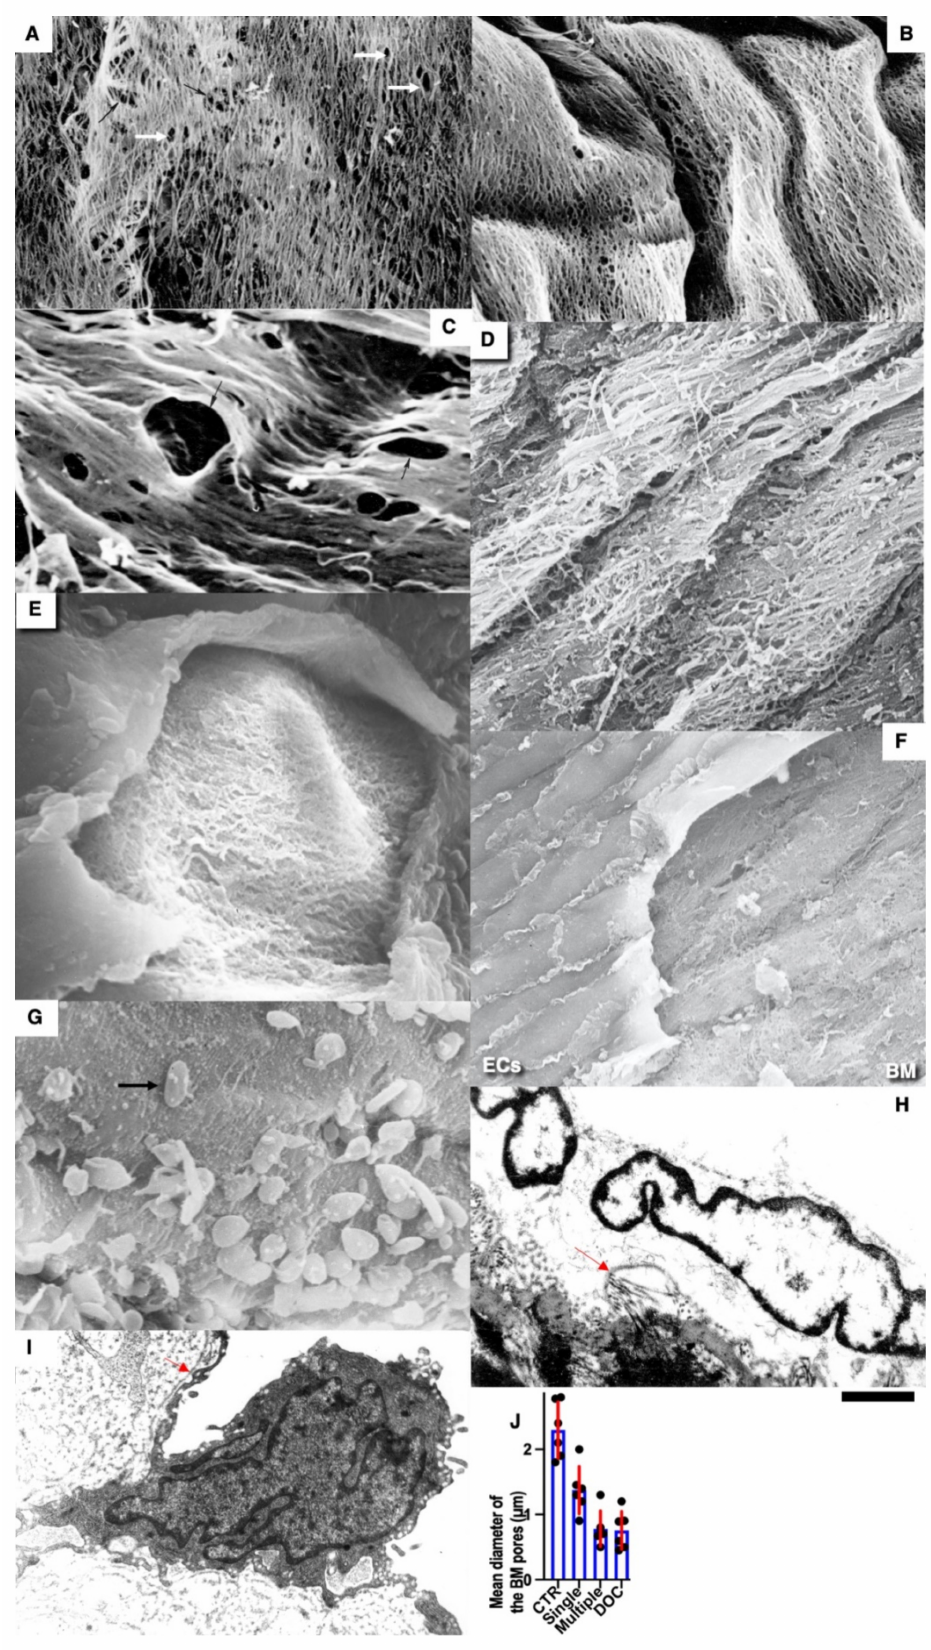
Figure 9. Decrease in the BM pore size after re-endothelialization. ( A , B ) Control. White arrows